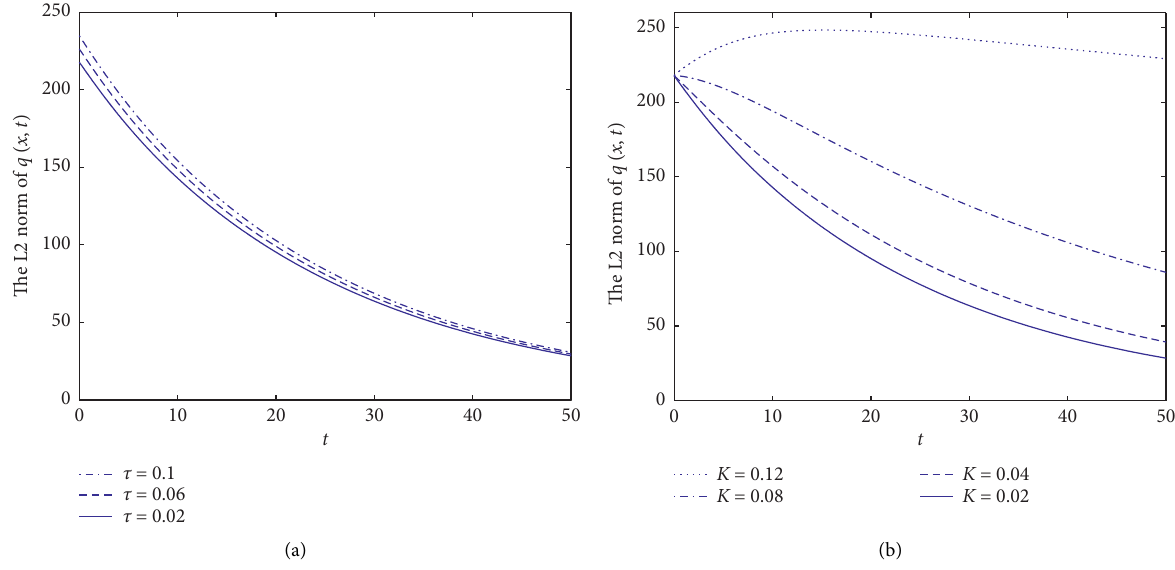
Figure 6: (a) The L 2 -norm of q ( x, t ) vs. time when b ( x ) � ( x / π ) − 1, q ( x, s ) � ( 1 + s )( π x 2 − x 3 /3 ) , α � 0 . 4 , β � 0 . 1 , κ � 0 . 02, and for different values of τ . (b) The L 2 -norm of q ( x, t ) vs. time when α � 0 . 4 , β � 0 . 1 , τ � 0 . 02, and for different values of κ